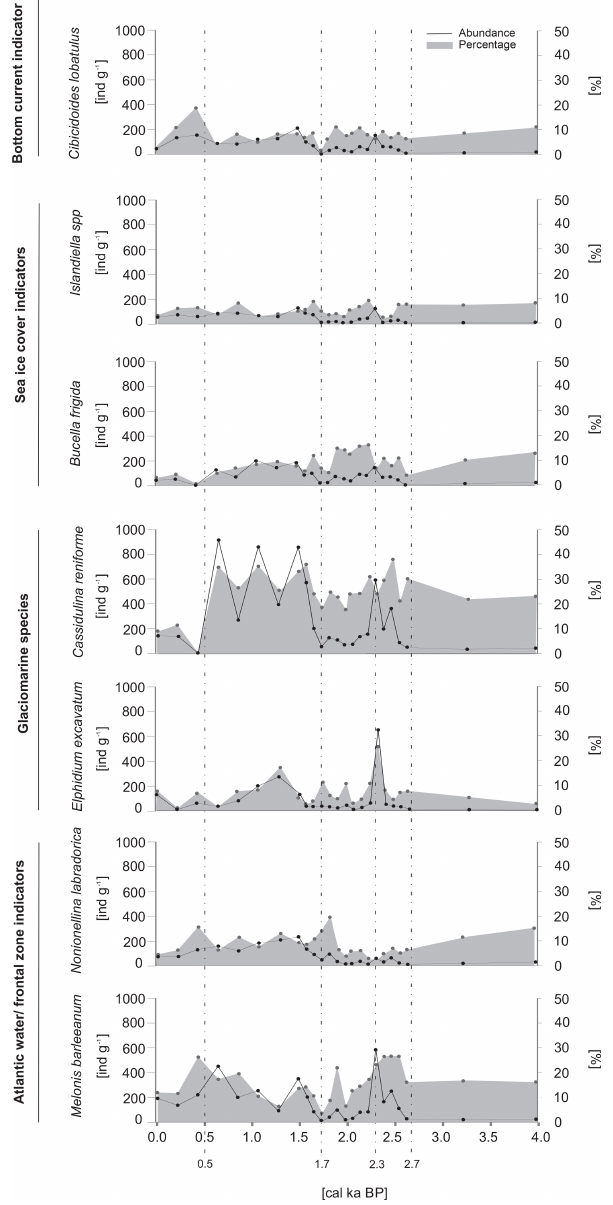
Figure 5. The absolute abundance (expressed as the number of in- dividuals per gram of dry sediment) and the percentage of the dom- inant benthic